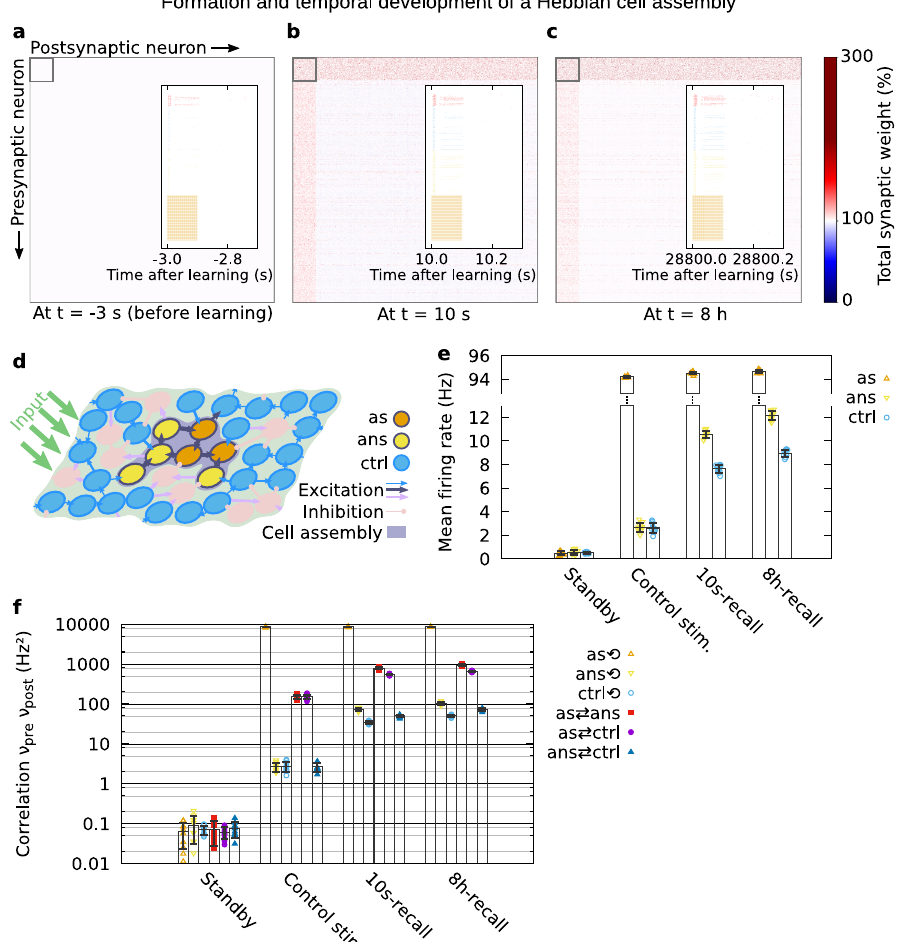
Fig. 3 Formation and temporal development of a Hebbian cell assembly and its functionality. a – c The matrix of total (early- plus late-phase) synaptic weights sorted by the stimulated neurons ( fi rst 150): a before learning, b ~10 s after learning, and c ~8 h after learning. The insets show the spiking during recall stimulation of the neurons in the cell assembly (colors as in d , e ) and of a random 5% fraction of the neurons in the remaining excitatory (blue) and inhibitory (red) populations. d Schematic of the three subpopulations during recall stimulation: the fraction of externally stimulated cell assembly neurons ( “ as ” ), the fraction of cell assembly neurons that are not stimulated ( “ ans ” ), and the remaining excitatory neurons acting as control group ( “ ctrl ” ). e The mean fi ring rates of the three subpopulations de fi ned in d , before learning and without recall (standby), before learning during control recall stimulation, upon recall 10 s after learning, and upon recall 8 h after learning. f Mean fi ring rate correlations (presynaptic multiplied by postsynaptic fi ring rate, averaged over neuron pairs) within and between subpopulations for the same protocols as in e . Synaptic weights, mean fi ring rates and mean correlations were averaged over ten trials. Error bars show the standard deviation. Parameters: w ie / h 0 = 4, w ii / h 0 =